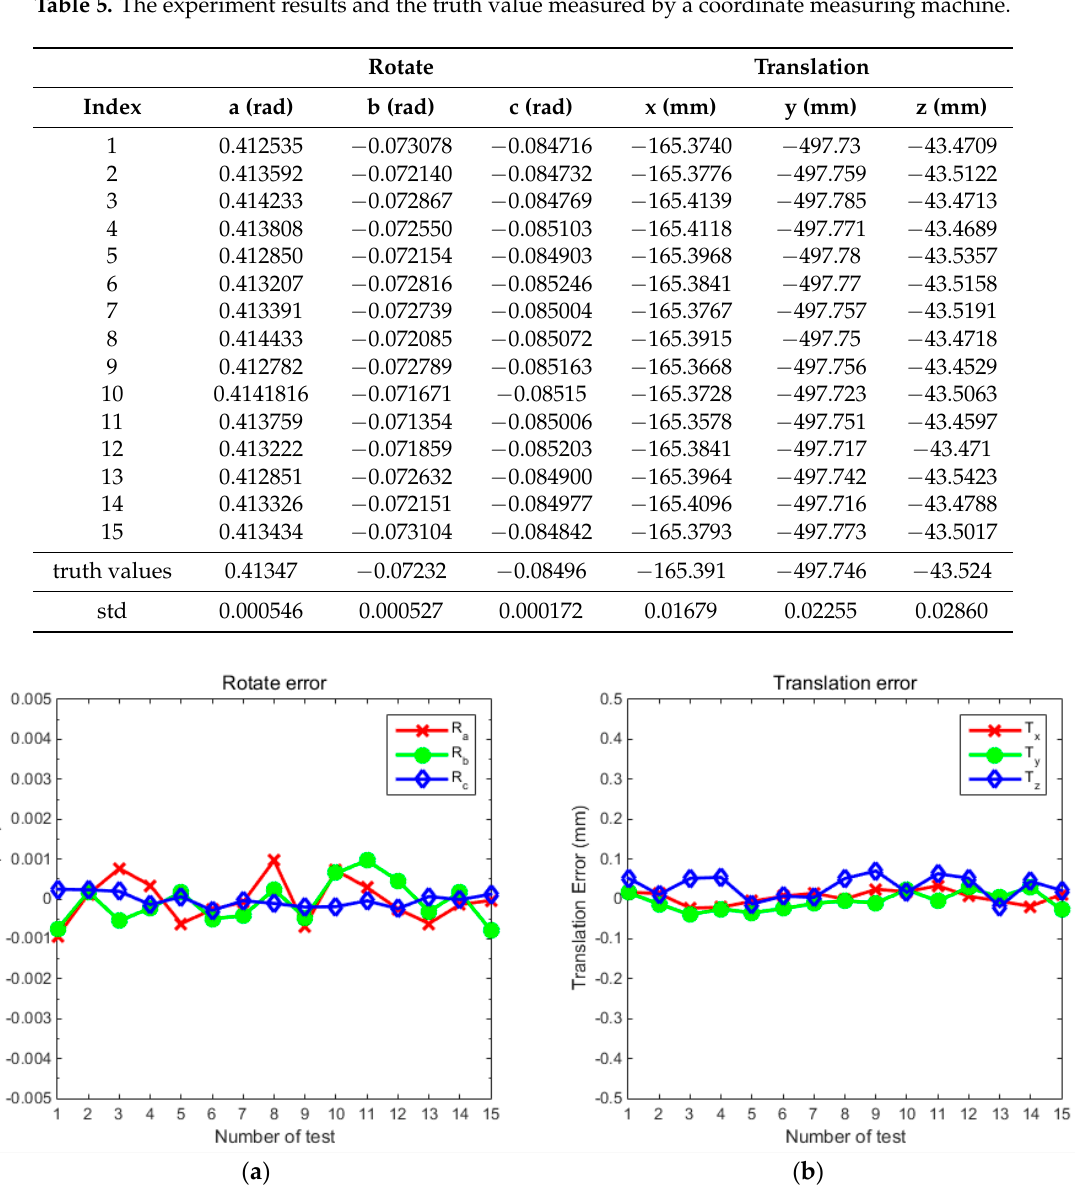
Figure 9. Errors between the calculated results and the ground truth data. ( a ) The figure on the left shows three rotation angle errors; ( b ) the figure on the right shows three translation errors.